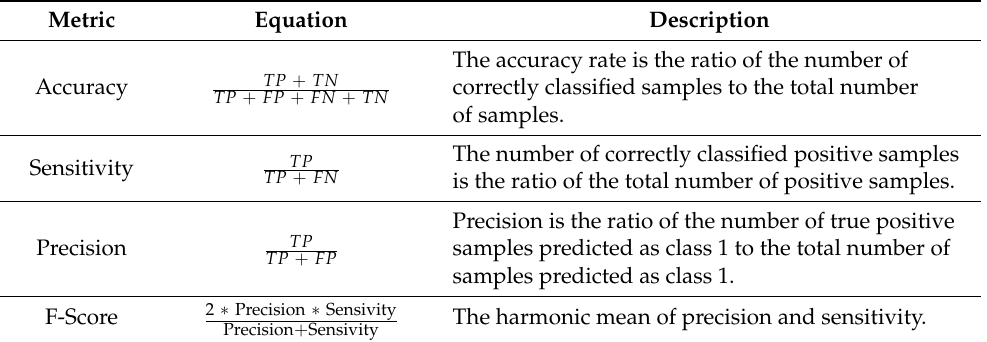
Figure 4. Complexity matrix [17]. Table 2. Basic concepts and equations used to evaluate model performance [28].